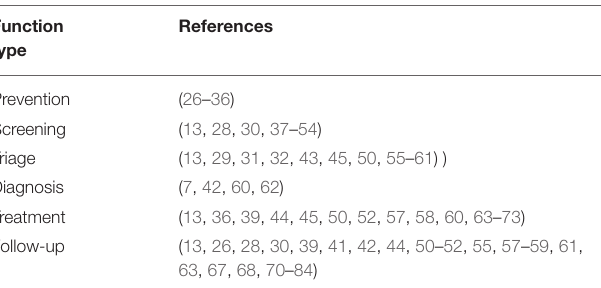
TABLE 3 | Function types in included